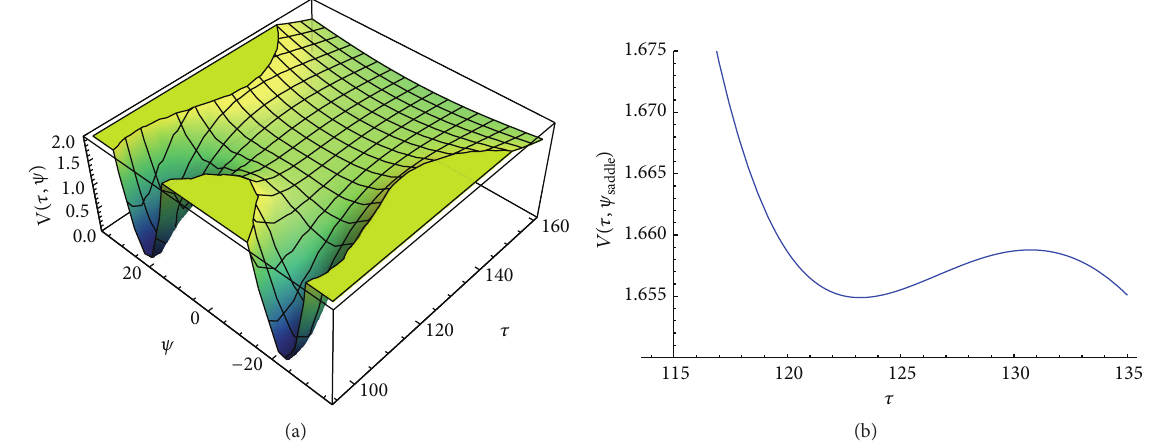
Figure 6: (a) corresponds to the racetrack scalar potential and (b) corresponds to the variation of the potential in the neighborhood of the saddle point (all are multiplied by 10 16 ). The parameter values are 𝐴 = 0.02 , 𝐵 = 0.035 , 𝑎 = 2𝜋/100 , 𝑏 = 2𝜋/90 , 𝐸 2 = 4.14668 × 10 −12 , and = −4 × 10 −5 𝑊 0